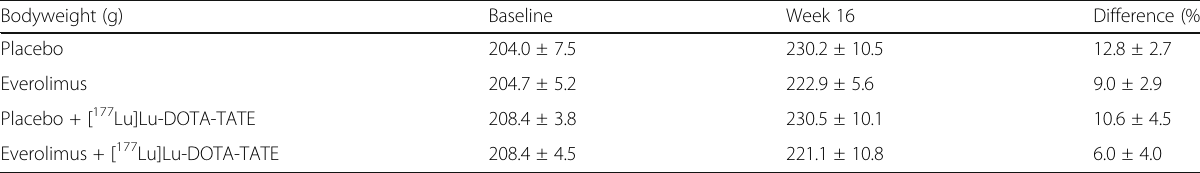
Table 1 Mean bodyweight at baseline, week 16 and corresponding differences with confidence intervals Bodyweight (g)